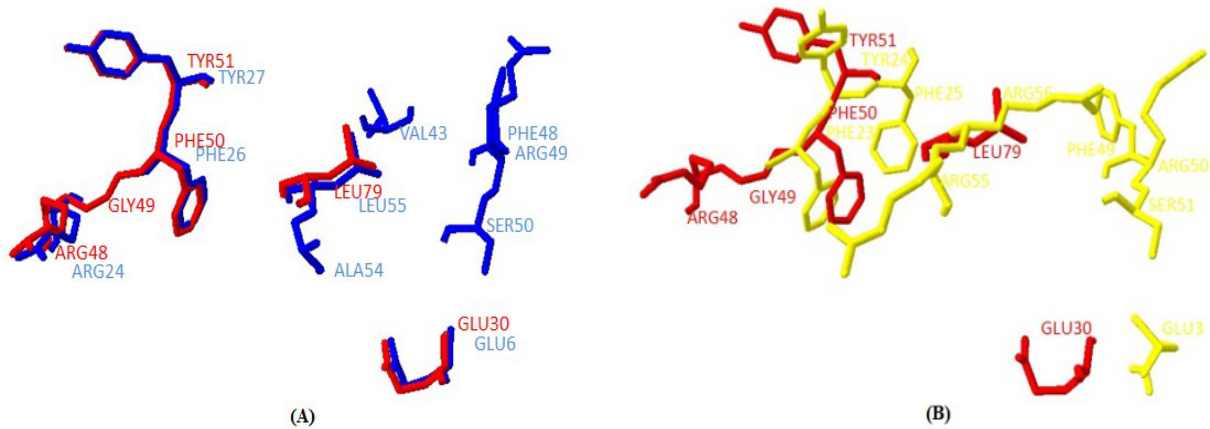
Figure 8. Comparison of the binding site residues of Tianzhu white yak IGF2 (red) with Homo sapiens IGF2 (blue) ( A ) and Homo sapiens IGF1 (yellow) ( B ). The binding site of the IGF from the two species and two amino acid sequence contains the highly conserved Phe and Tyr residues. This comparison indicated very high similarity between the predicted binding sites of yak IGF2 and human IGF2.